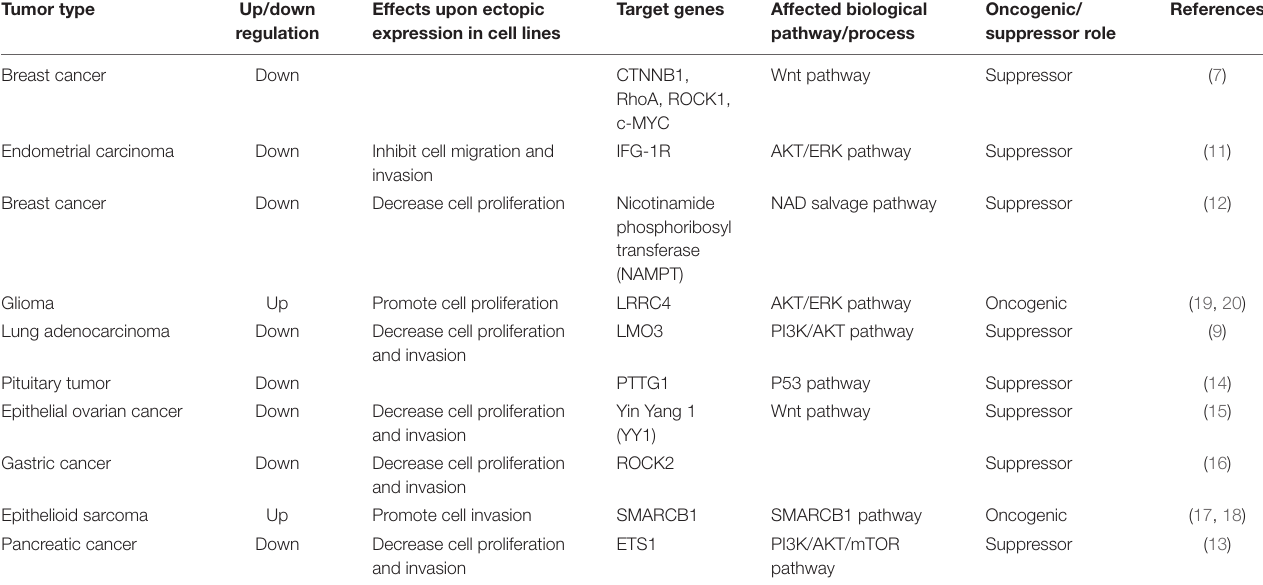
TABLE 1 | MiR-381 participates in multiple signaling